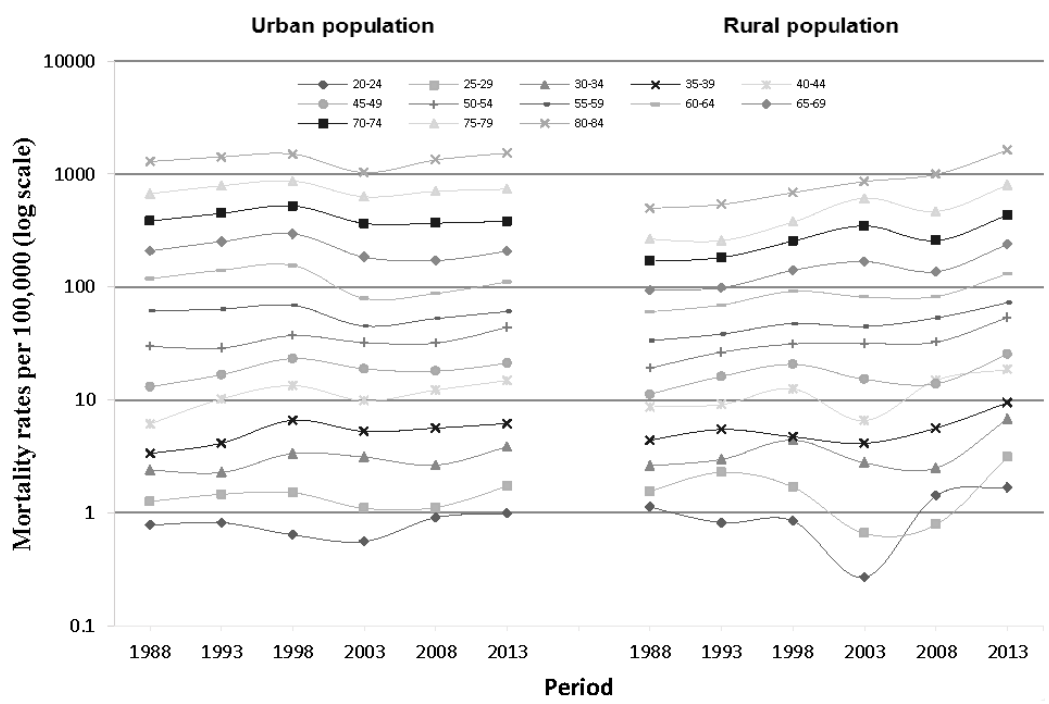
Figure 3. Period-specific IHD mortality rates in urban and rural China, by age group.